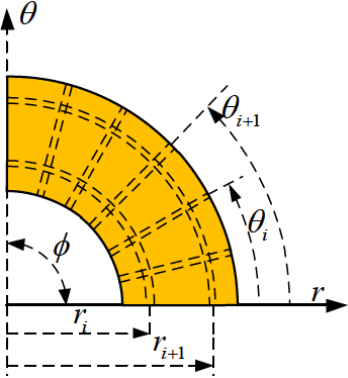
Figure 11: Schematic diagram of a laminated annular sector plate with arbitrary internal radial line and circumferential arc